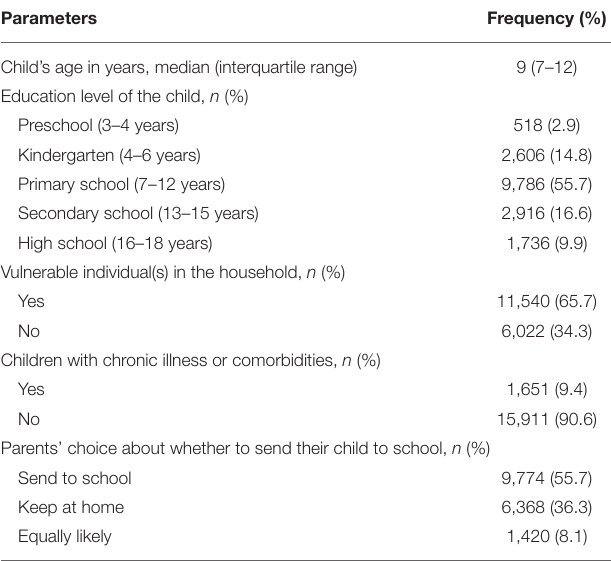
TABLE 1 | General characteristics of respondents’ children ( n = 17,562).